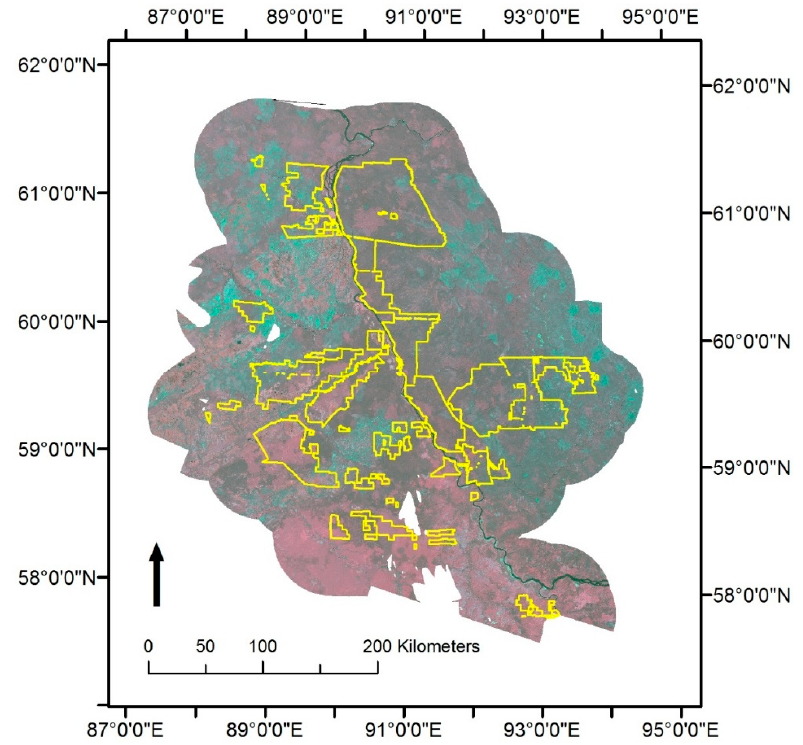
Figure 3. False color image presenting a leaf-on mosaic covering the area of interest (area delineated in yellow).